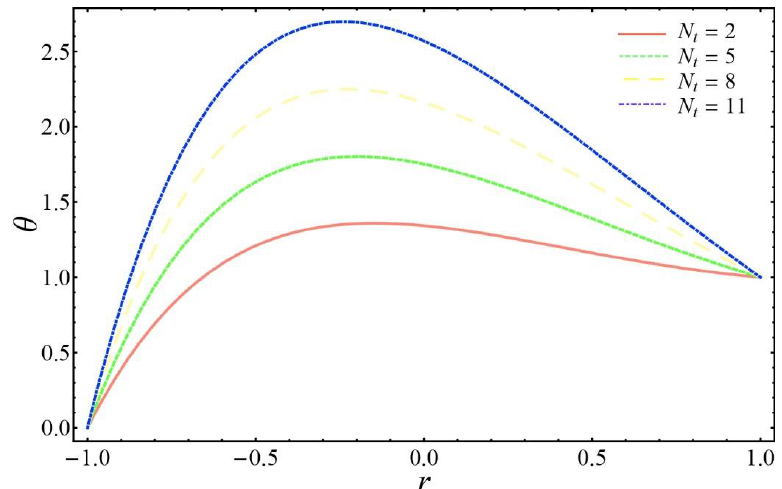
Figure 7. Alteration of 𝑁 𝑡 on θ when 𝑥 = 0.5; 𝑡 = 0; 𝑄 = 10; 𝛽 = 0.2; 𝜖 = 0.2; 𝑁 𝑏 = 5; 𝑁 𝑑 = 2; 𝑘 = 2.